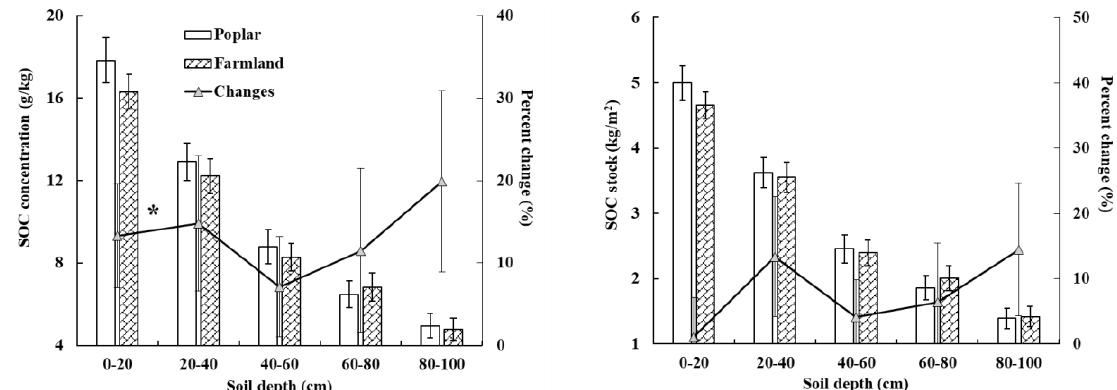
Figure 4. The effects of shelterbelt on total SOC concentrations and stocks in 0 – 20 cm, 20 – 40 cm, 40 – 60 cm, 60 – 80 cm, and 80 – 100 cm. Broken lines are percent changes of total SOC concentrations and stocks, * indicates the significant differences at p < 0.05 between the changes in shelterbelt − induced and farmlands in same soil layer. Error bars are the standard errors.